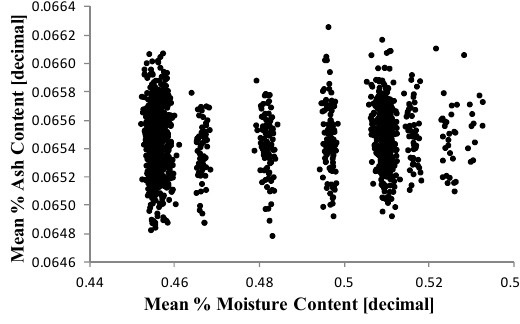
Figure 8. Average ash content vs. MC (schedule (*)).